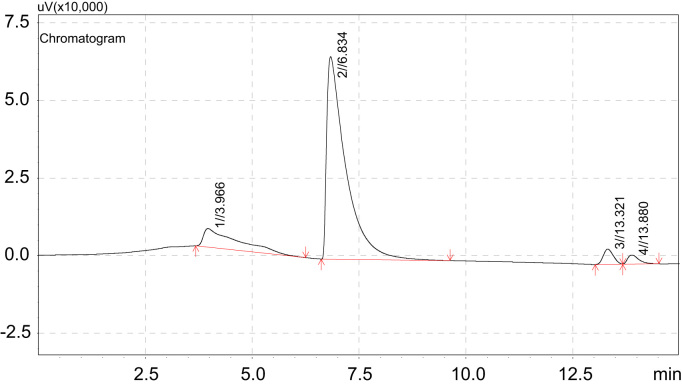
Sample standard.